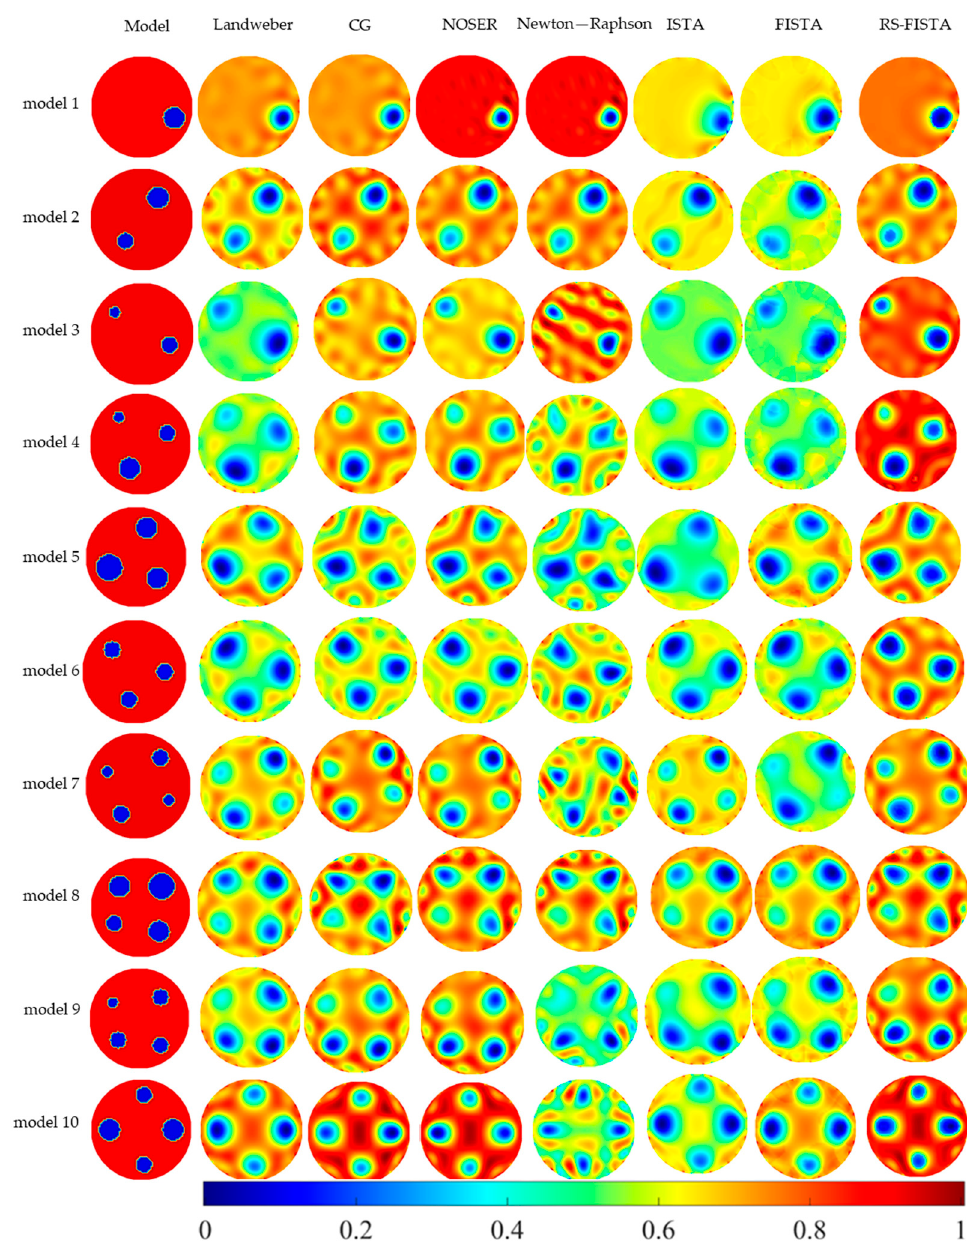
Figure 2. Simulation imaging results of different algorithms.